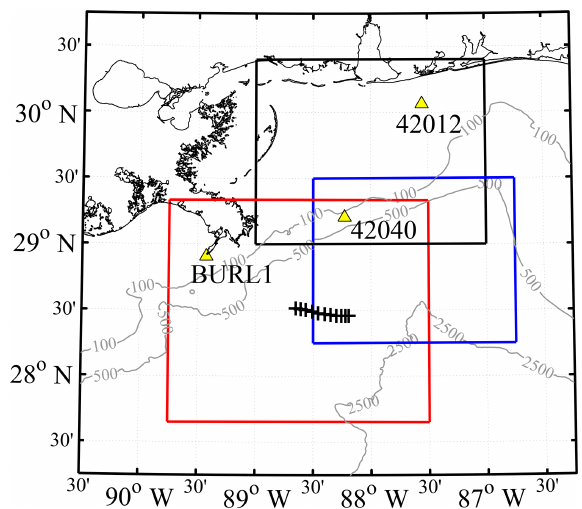
Figure 1. Research area in the northern Gulf of Mexico, ESE of the Mississippi River Delta. National Data Buoy Center (NDBC) buoy locations used for validation of UWIN-CM wind and wave data are shown in yellow triangles. Domains corresponding to each high wind event analyzed are shown in the red (24 February), blue (22 January) and black (20 March) boxes. Black hash marks show the ship track where data in Fig. 2 were collected. Grey contours show the bathymetry at 100, 500 and